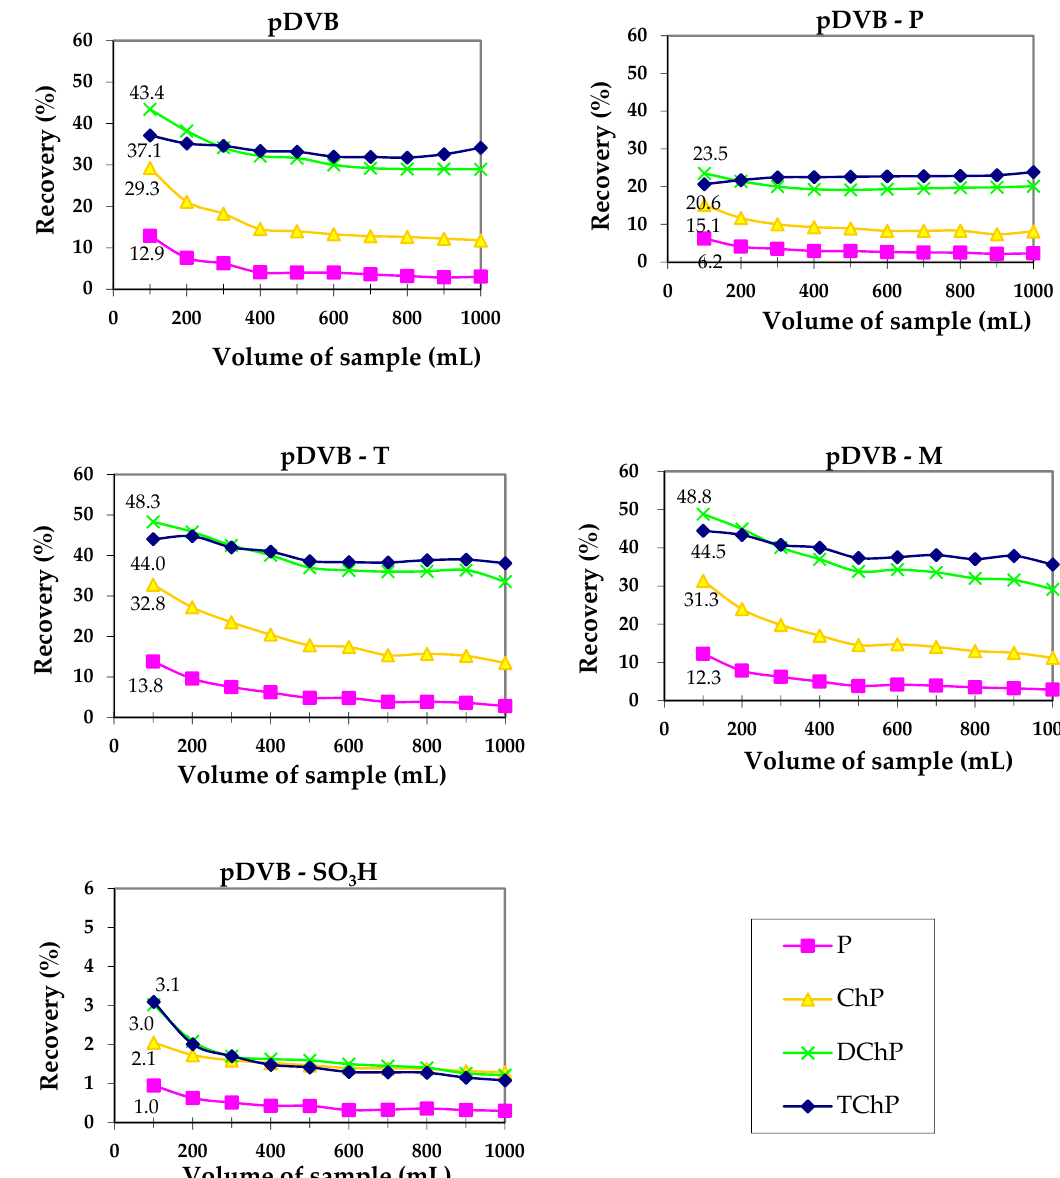
Figure 5. Results of solid phase extraction (SPE) experiments obtained for the mixture of phenols.